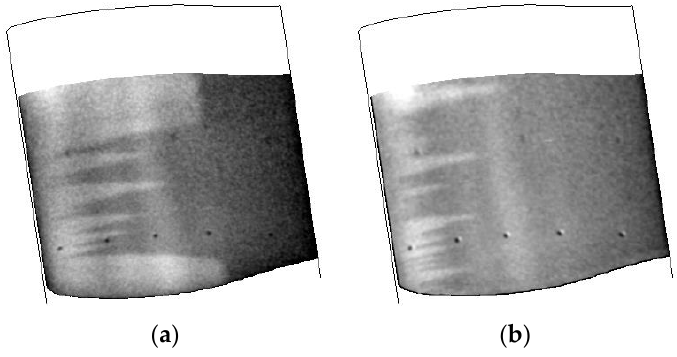
Figure 12. Temperature images collected at different Reynolds numbers. Data were collected at T = 200 K, Mach 0.7: ( a ) Re = 32.8 M/m; and ( b ) Re = 49.2 M/m.